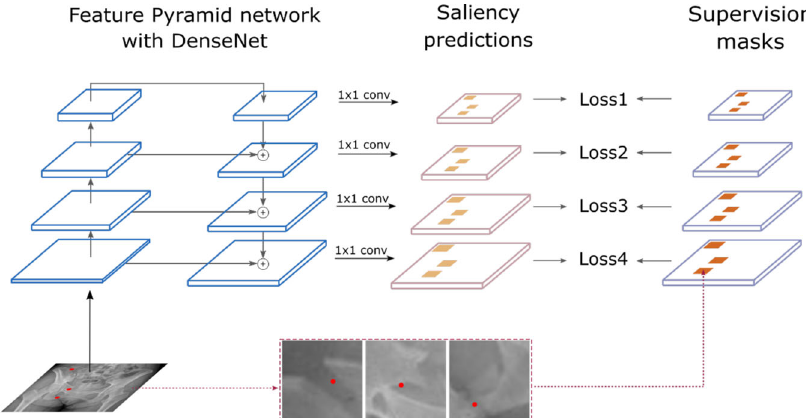
Fig. 4 The illustration of bone fracture classi fi cation and localization system. The proposed bone fracture classi fi cation and localization system trained with point-based supervision signals. The network uses PXR images as input and extracts different levels of feature abstractions through a bottom-up pathway, which is further fused by a top-down path.